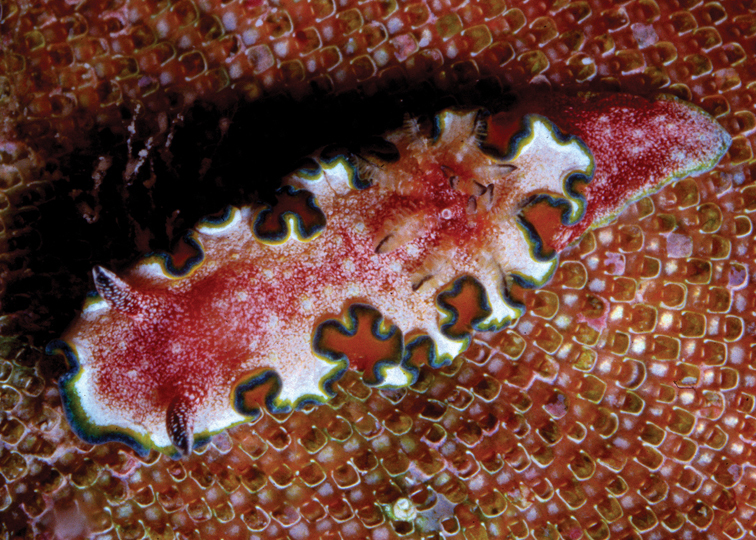
Glossodoris cincta, 15 mm, Maldives, on the bryozoan Steginoporella, photo: J Hinterkircher.